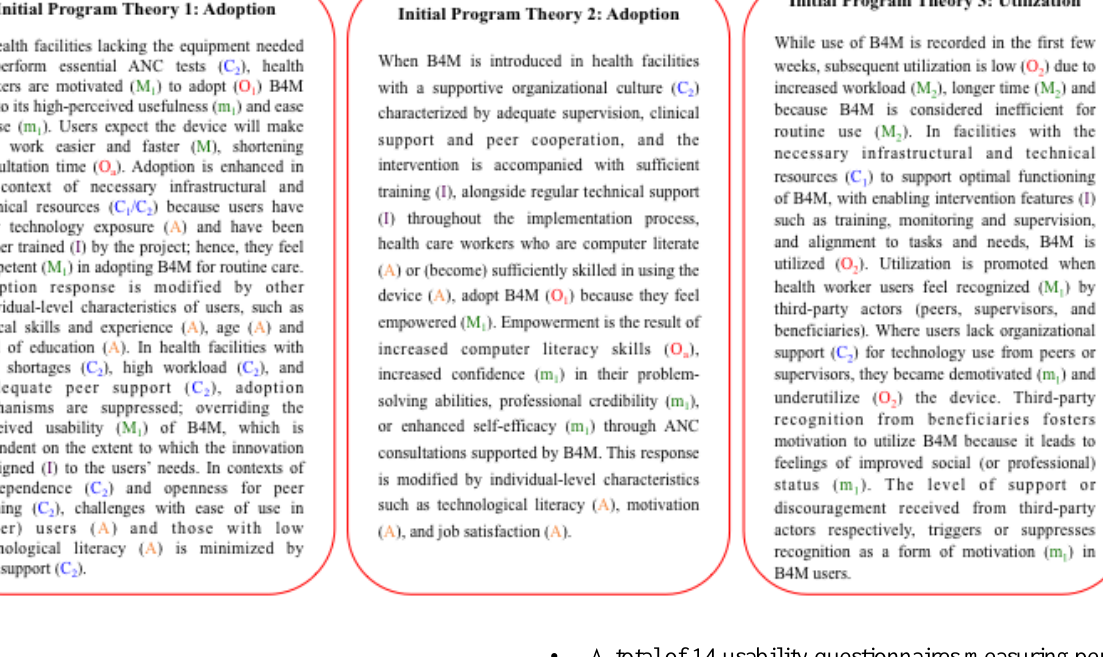
Figure 1. Initial program theories. Features and characteristics of the intervention- (I); Contextual factors are denoted (C 1 ) and (C 2 ) for environmental and health system context respectively; Outcomes are denoted (O 1 ) or (O 2 ) representing adoption and utilization respectively; Mechanisms are identified (M 1 ) or (M 2 ) following the outcomes they are linked to, with related explanatory mechanisms further depicted (m 1 ) or (m 2 ); Actor or user characteristics are denoted (A); (O a ) represents additional outcomes. ANC: antenatal care; B4M: